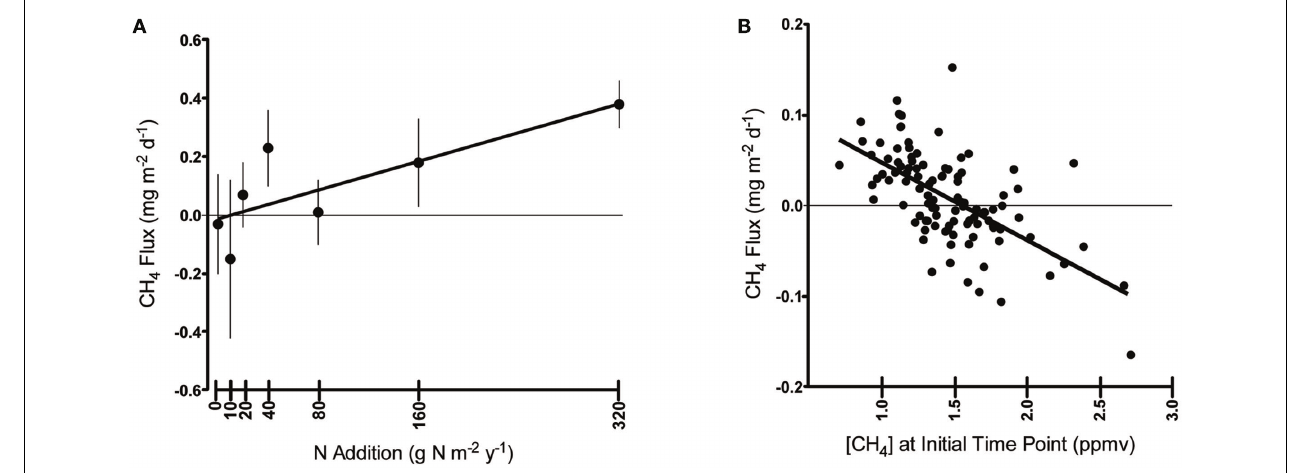
FIGURE 1 | Salt marsh field methane flux after 7months of fertilization: (A) CH 4 flux along the N gradient. Regression: Flux (mg CH 4 m − 2 day − 1 ) = 0.00123* N addition (mg CH 4 m − 2 day − 1 ) – 0.0122, R 2 = 0.23,